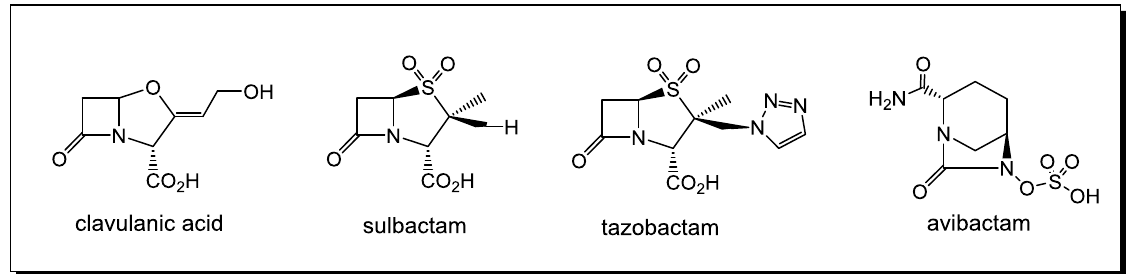
Figure 2. Clinically relevant β-lactamase